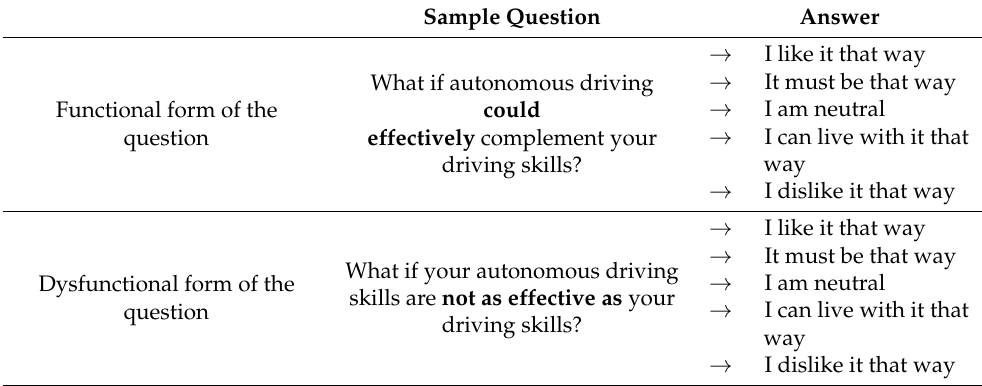
Table 1. Kano model questionnaire type.